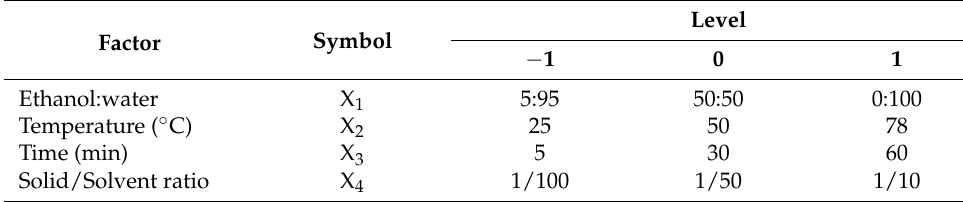
Table 3. Independent variables and levels for Box-Behnken experimental